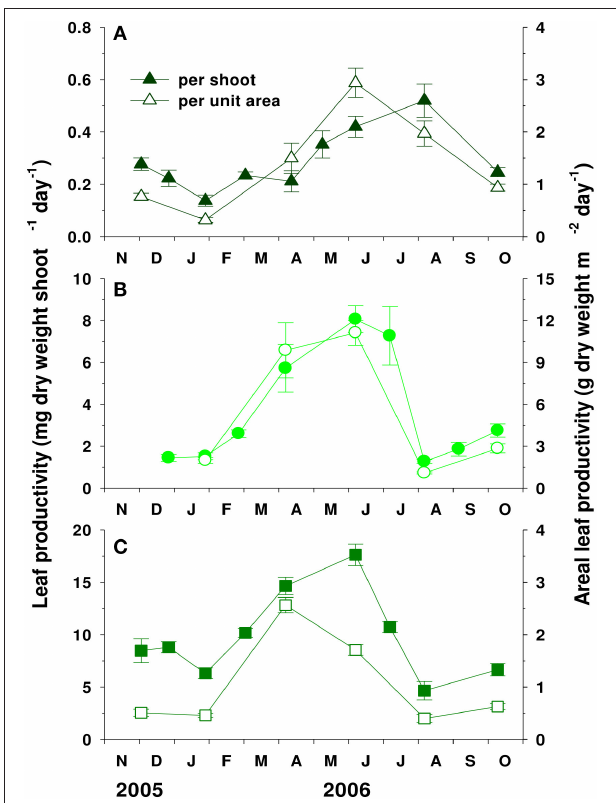
FIGURE 6 | Seasonal variations in leaf productivity per shoot and per unit area of Zostera japonica (A) , Zostera marina (B) , and Zostera caespitosa (C) in Koje Bay. Values are expressed as mean ± SE ( n = 6–10).